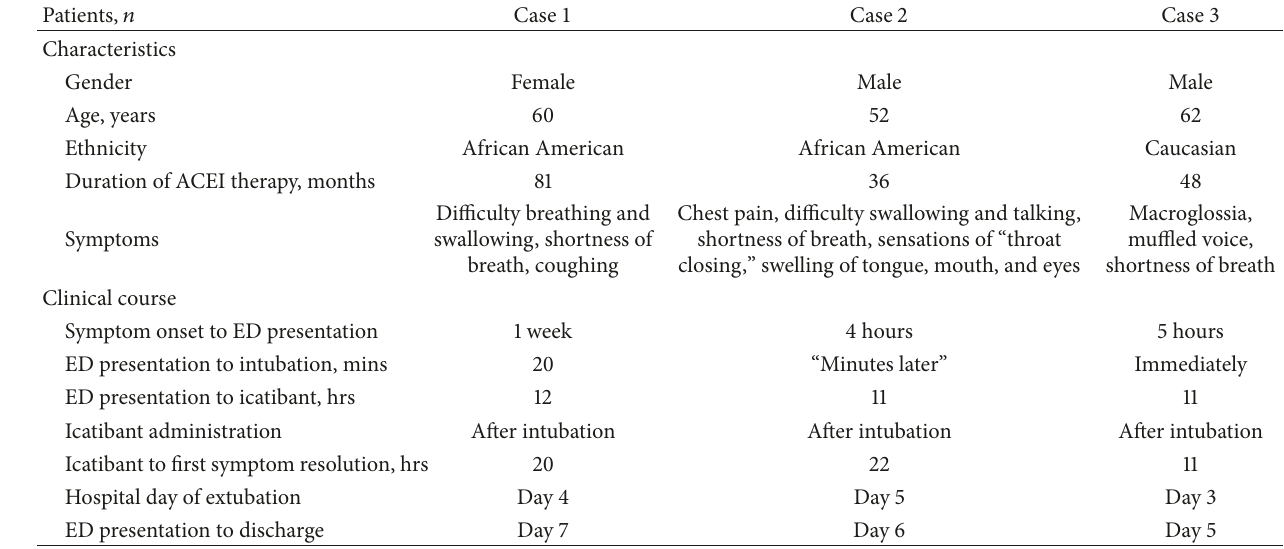
Table 1: Summary of patient